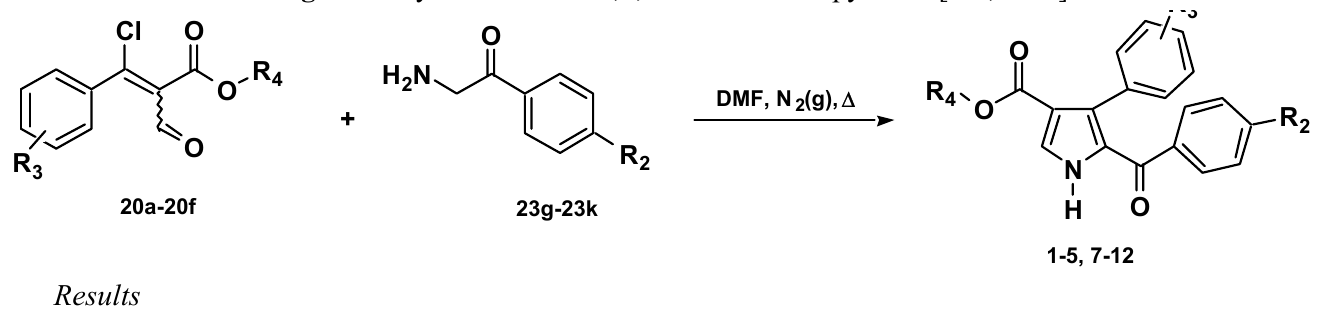
Table 1: Substitutions on the pyrroles screened for in vivo hypolipidemic activity in rodents.